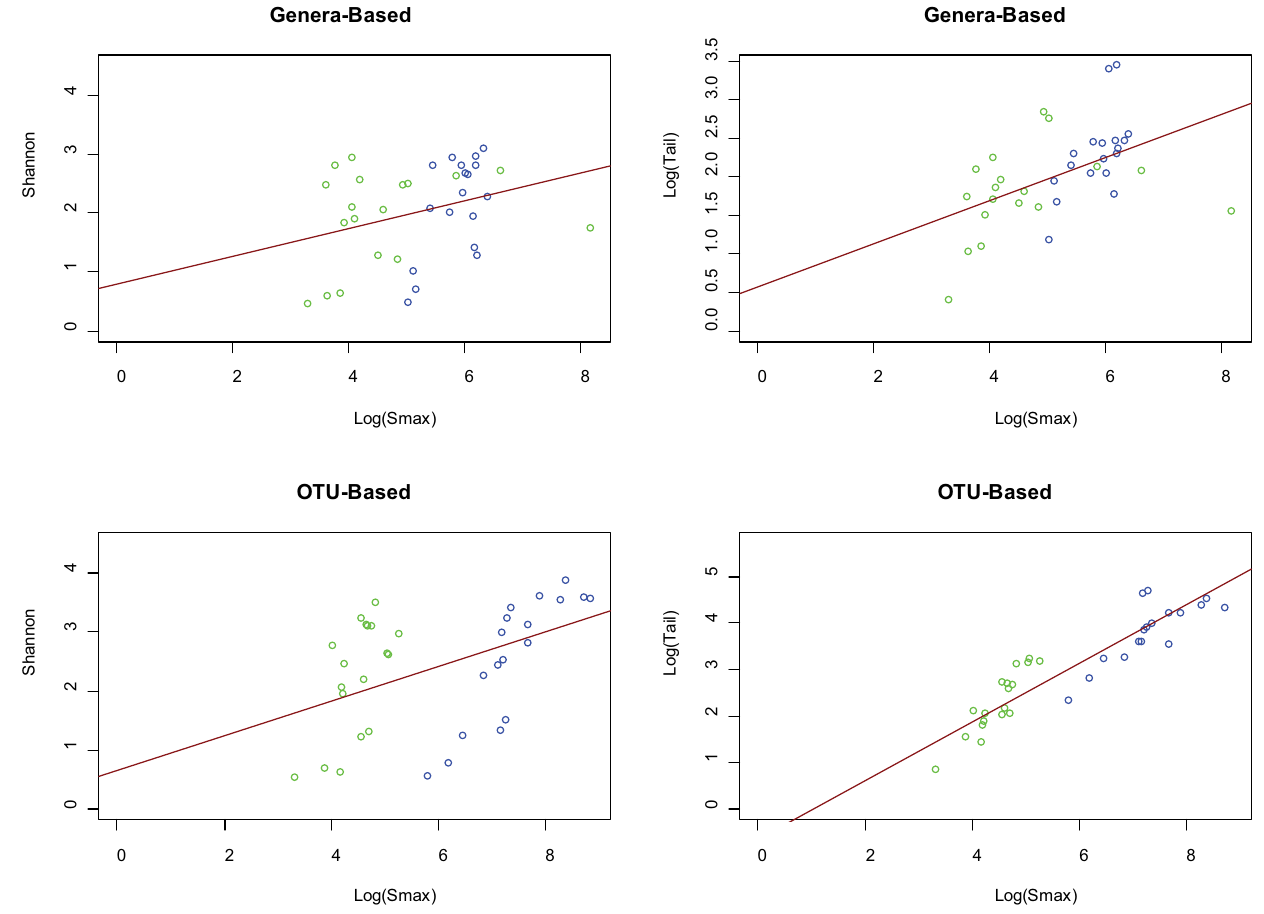
Figure 6. Comparison of all and ‘‘common’’ taxonomic units and their effect on the Shannon and t statistics. For both genera-based and OTU-based taxonomic units, the Shannon diversity index and t were compared against the median estimated S max on all (blue) and common (green) taxonomic units. Each point in the scatterplot represents one of the 18 body habitats. There is a closer relationship between t and S max than for the Shannon diversity index, for both genera and OTU based profiles. The red line represents a simple regression line across all points.